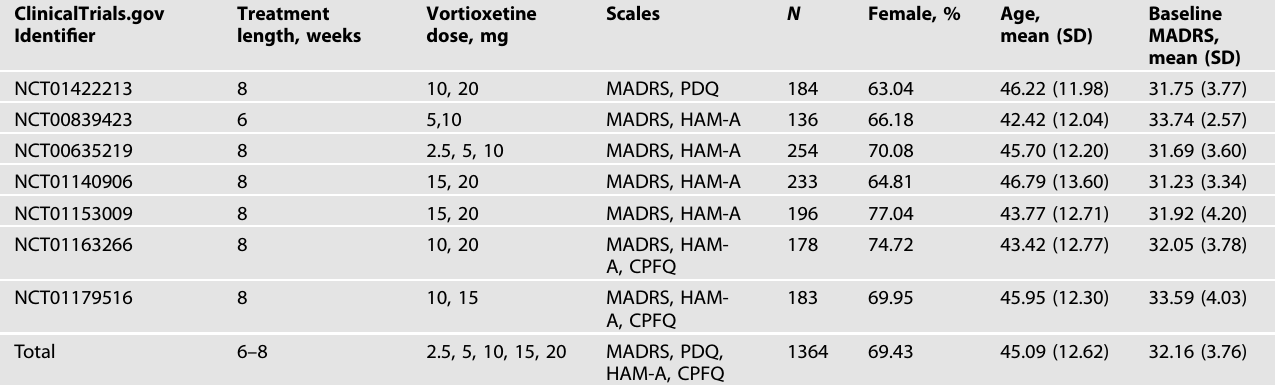
Table 1. Characteristics of randomized, double-blind, placebo-controlled clinical trials included in the clinical test sample. ClinicalTrials.gov Identi fi